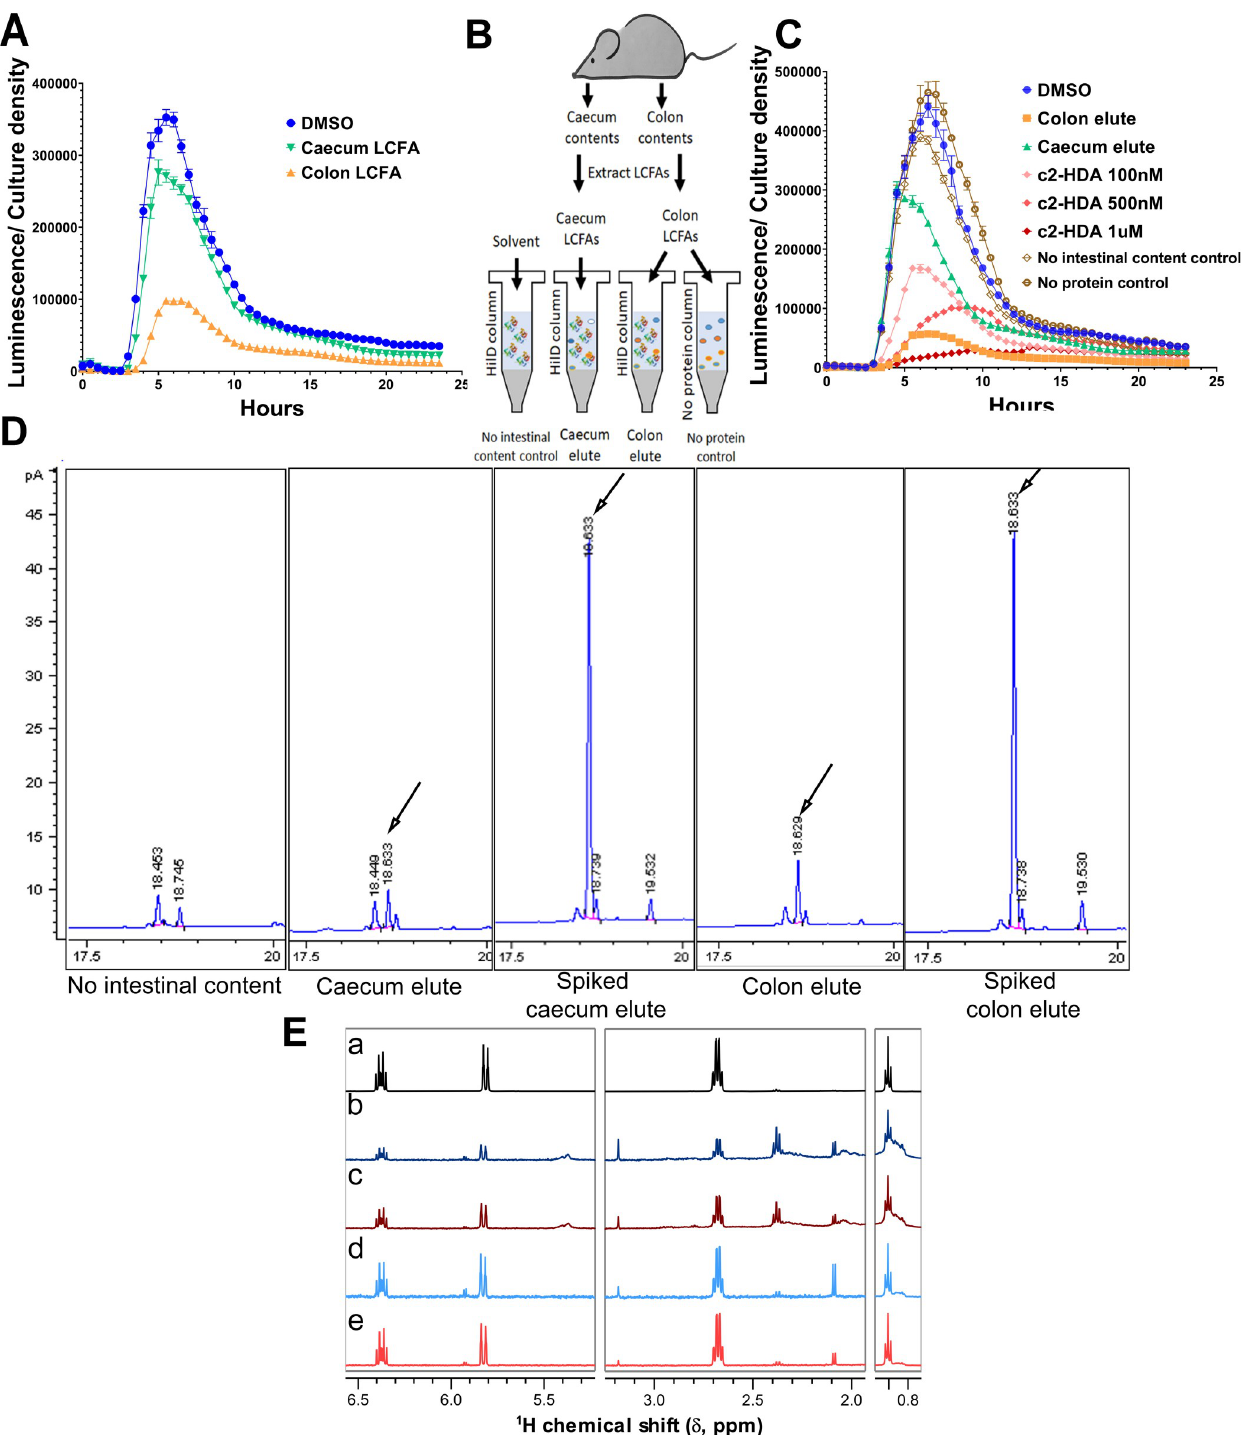
Fig 1. The invasion-repressing signal factor c2-HDA is present in the murine intestine. (A) Salmonella strain carrying hilA-luxCDABE transcriptional reporter fusion was grown in presence of LCFAs extracted from murine caecum or colon; luminescence was normalized to bacterial culture density. Data show mean ± SD of five replicates. (B) Summary of the HilD-affinity experiments. Caecal and colon contents of C57BL/6 mice (n = 15) were pooled, LCFAs were extracted and applied to HilD-His bound to TALON beads. Columns were washed and HilD-fatty acid complex was eluted. Control columns where no extract was applied (no intestinal content) and columns without HilD (no protein control) were treated similarly. All elutes underwent organic extraction and were finally dissolved in DMSO. (C) Salmonella strain carrying hilA-luxCDABE transcriptional reporter fusion was grown in the presence of caecal or